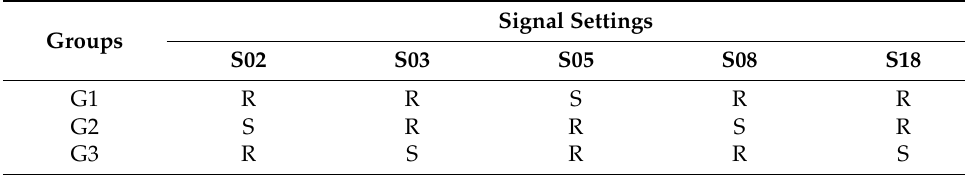
Table 5. Satellite signal type.